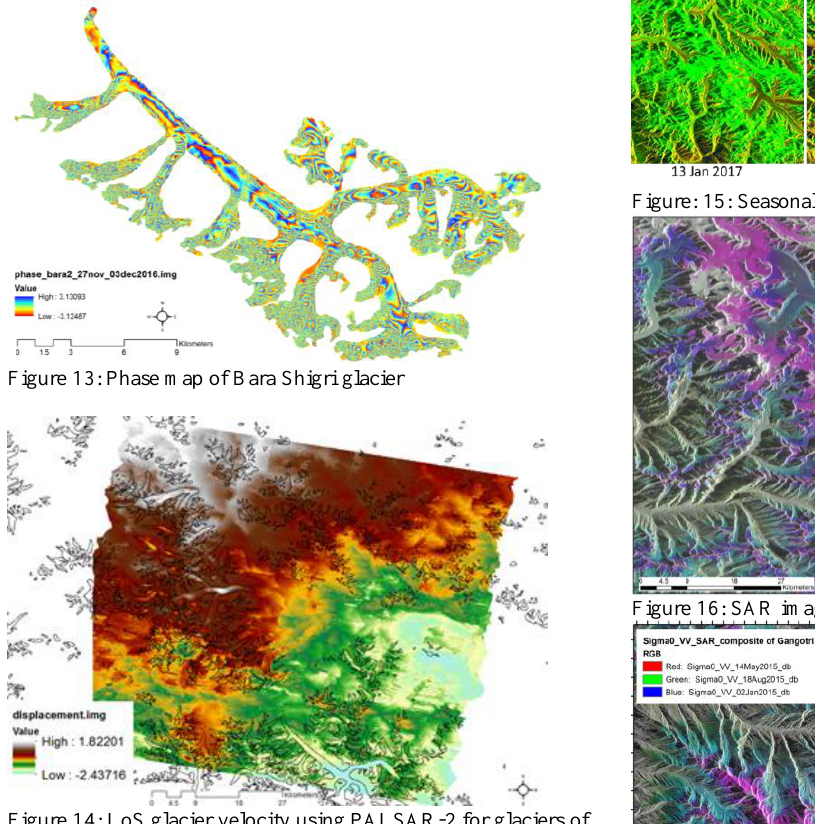
Figure 14: LoS glacier velocity using PALSAR-2 for glaciers of Chandra basin, 10-24 Mar 2015.